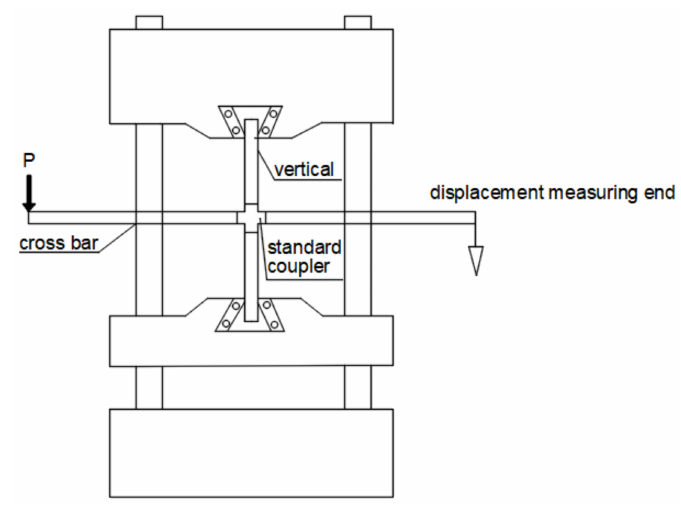
Figure 1. Test setup diagram.